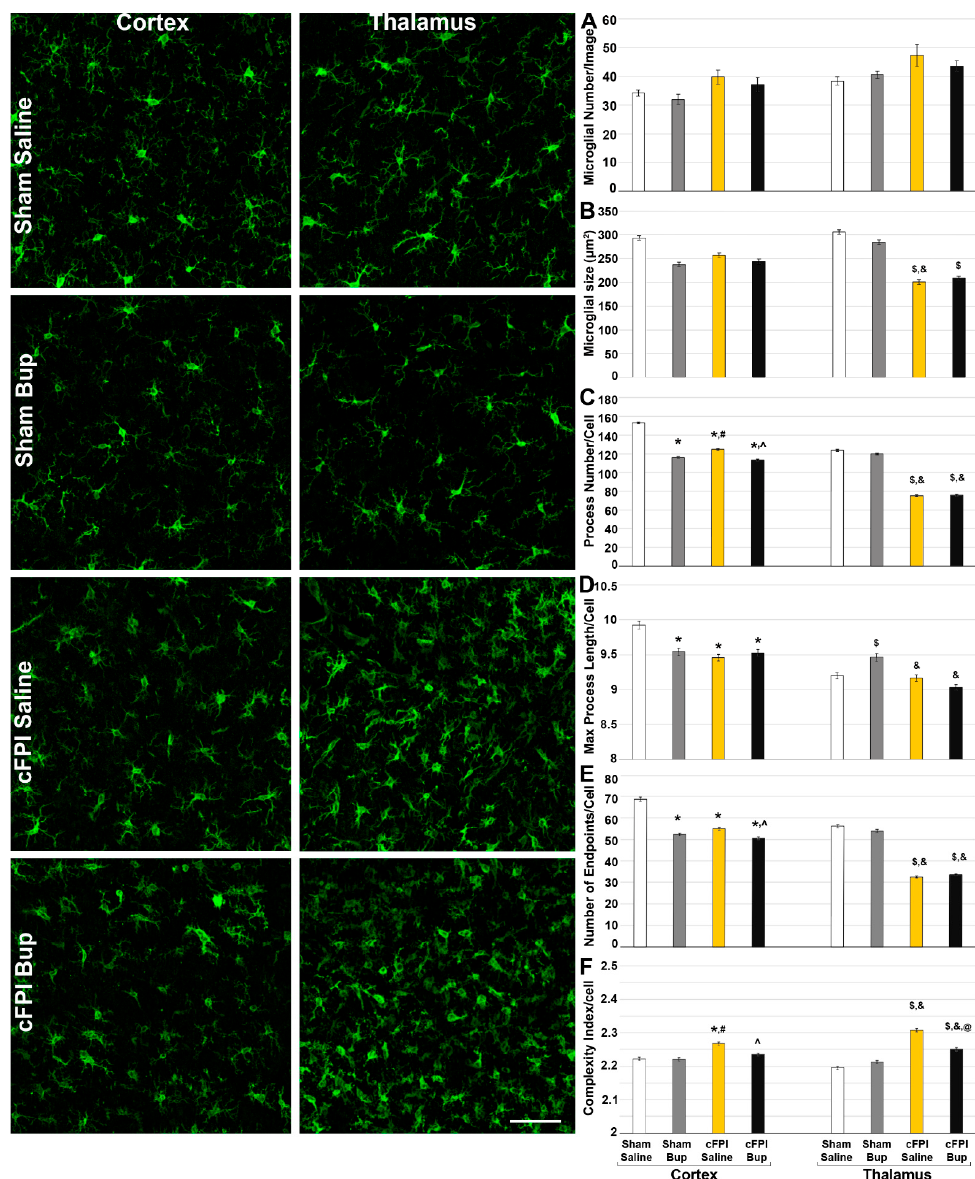
Figure 4. Bup-SR-Lab (Bup) treatment is associated with microglial morphologic alterations primar- ily within the cortex 4w following Bup-SR-Lab treatment. Representative photomicrographs of Iba-1 labeled microglia in the cortex and thalamus from rats 4w post-cFPI or sham and treated with saline or Bup. Bar graphs depicting microglial characteristics and morphology indicative of activation: ( A ) number of microglia/image analyzed, ( B ) average microglia cell size, ( C ) Number of processes/microglia, ( D ) average maximum process length/microglial cells, ( E ) number of process end points/cell, and ( F ) the average complexity index of the microglial process network. Microglial morphologies were significantly different in the cortex of sham control rats treated with Bup com- pared to cortical microglia in sham and saline treated control animals. Additionally, microglial process number, endpoint number, and process network complexity was altered in the cortex, but not the thalamus of Bup-treated cFPI rats compared to their saline-treated counterparts, suggesting regional specificity in the effects of Bup. n = 6 rats/group. Mean ± SEM. Scale = 50 µ m. * p < 0.05 compared to sham saline cortex, # p < 0.05 compared to sham Bup cortex, $ p < 0.05 compared to sham saline thalamus, & p < 0.05 compared to sham Bup thalamus, ˆ p < 0.05 compared to cFPI saline cortex, @ p < 0.05 compared to cFPI saline